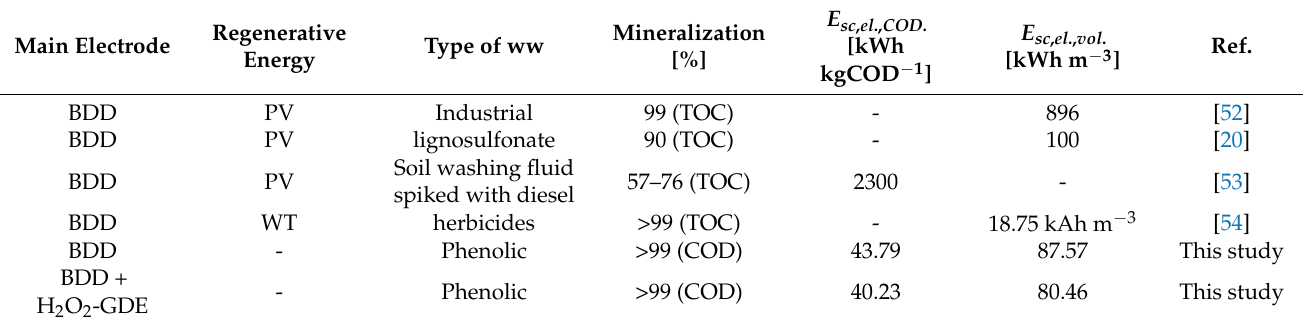
Table 4. Comparison of the specific energy values per volume and COD of the electrolysis systems with those of the BDD-based electrochemical oxidation systems from literature, which were driven by regenerative energy. Here, ww, CE, PV, and WT denote the concentration wastewater, current efficiency, photovoltaic energy, and wind turbine, respectively.